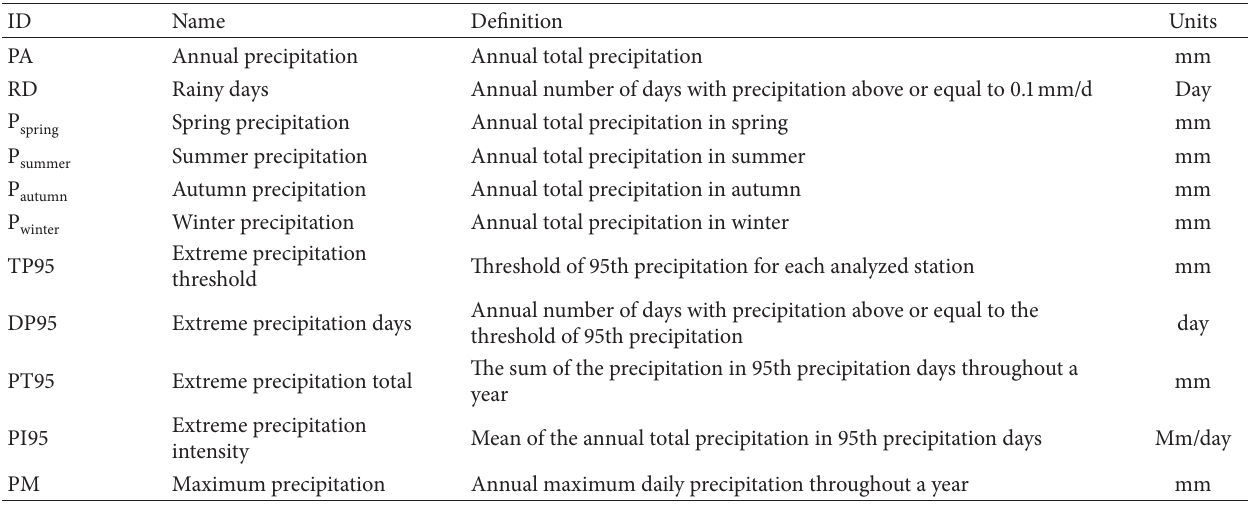
Table 1: Definition of precipitation